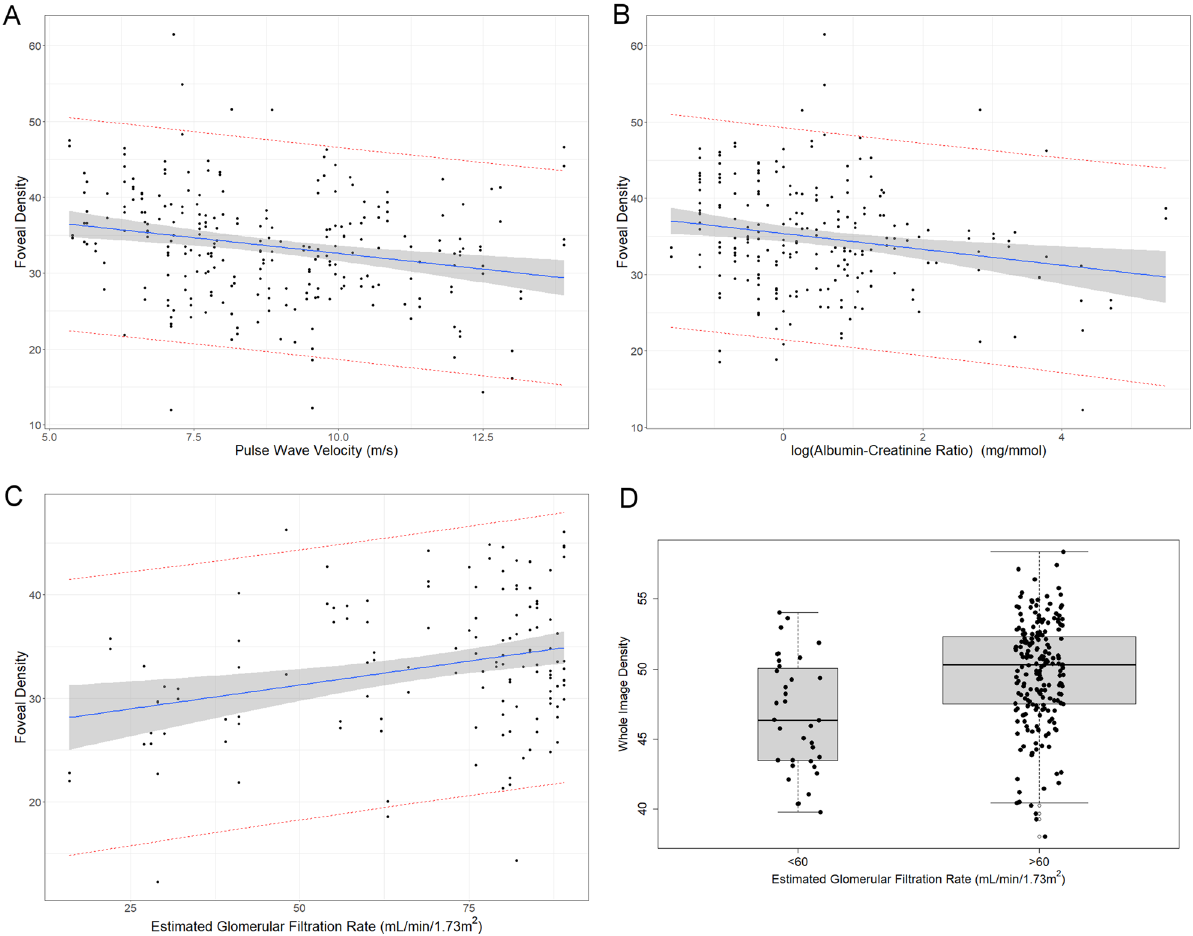
Figure 3. Scatterplots of foveal density against measures of hypertension mediated organ damage, including the unadjusted linear regression model fits (blue line) with the mean (grey area) and observed (red dashed lines) 95% confidence intervals. ( a ) Pulse wave velocity; ( b ) log (albumin–creatinine ratio); ( c ) estimated glomerular filtration rate (eGFR > 90 excluded), ( d ) boxplot comparing whole image density between groups classified by estimated glomerular filtration rate < > 60).